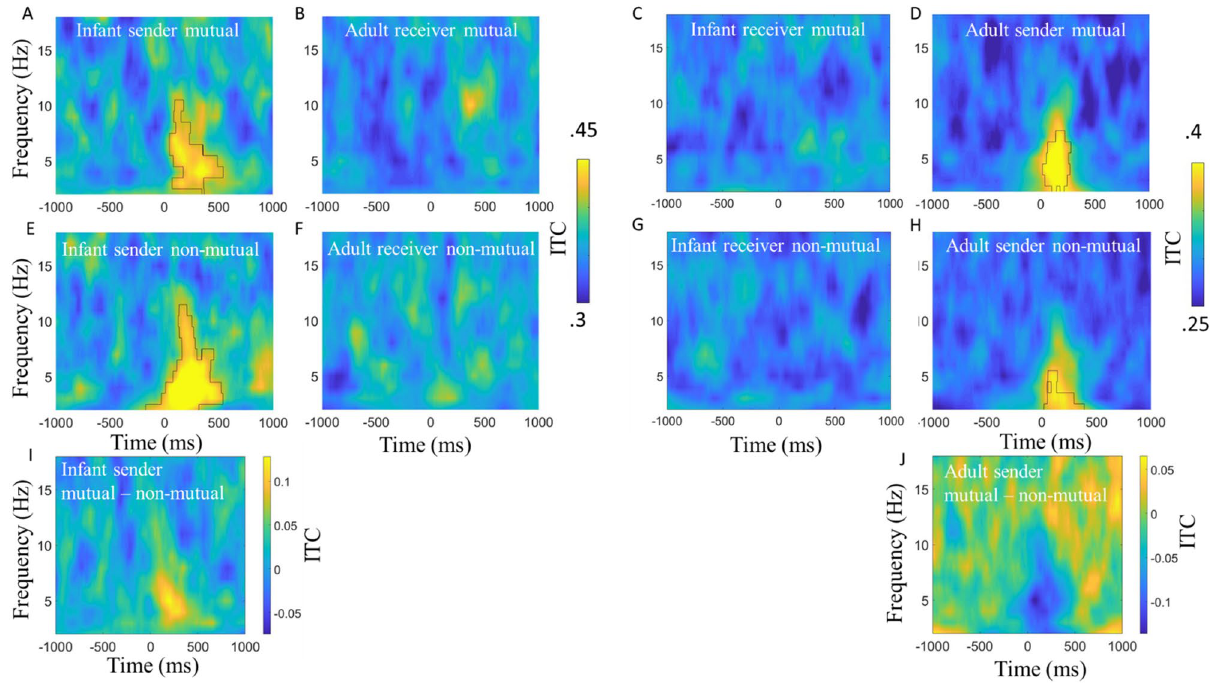
Figure 7. Inter-trial phase coherence time-locked to naturally occurring mutual and non-mutual gaze onsets. ( A ) Infant ITC relative to infant sender mutual gaze onsets. ( B ) Adult ITC relative to adult receiver mutual gaze onsets. ( C ) Infant ITC relative to infant receiver mutual gaze onsets. ( D ) Adult ITC relative to adult sender mutual gaze onsets. ( E ) Infant ITC relative to infant sender non-mutual gaze onsets. ( F ) Adult ITC relative to adult receiver non-mutual gaze onsets. ( G ) Infant ITC relative to infant receiver non-mutual gaze onsets. ( H ) Adult ITC relative to adult sender non-mutual gaze onsets. For all, black borders highlight activity that was significantly greater than baseline after cluster correction for multiple comparisons using p = 0.05. ( I ) Difference plot between infant sender mutual versus non-mutual gaze onsets. ( J ) Difference plot between adult sender mutual versus non-mutual gaze onsets. Hotter colours indicate more ITC for mutual versus